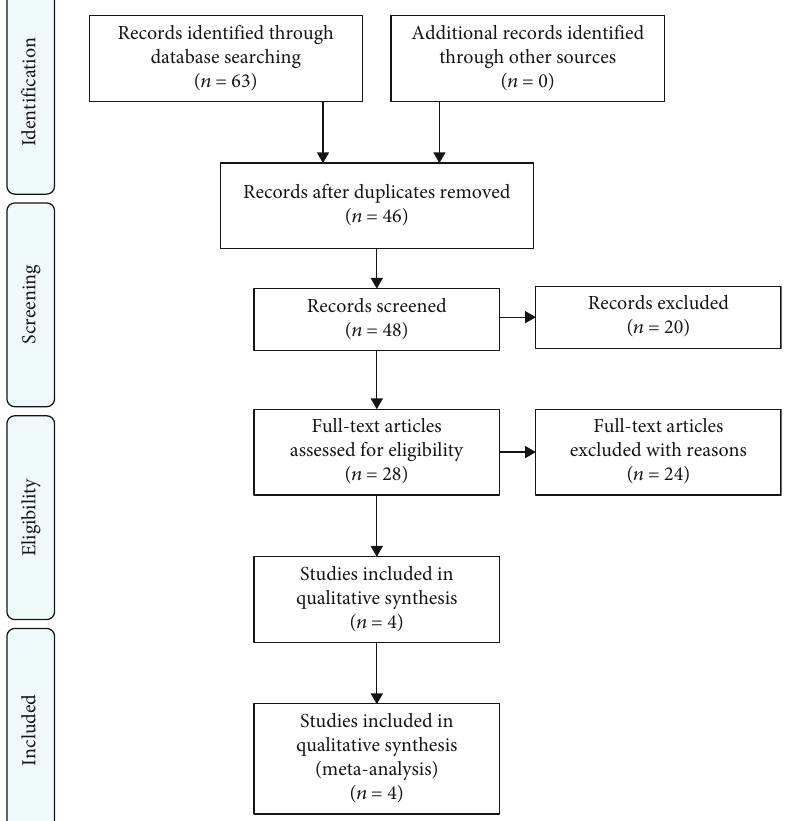
Figure 1: The fl ow chart shows the process for identifying relative